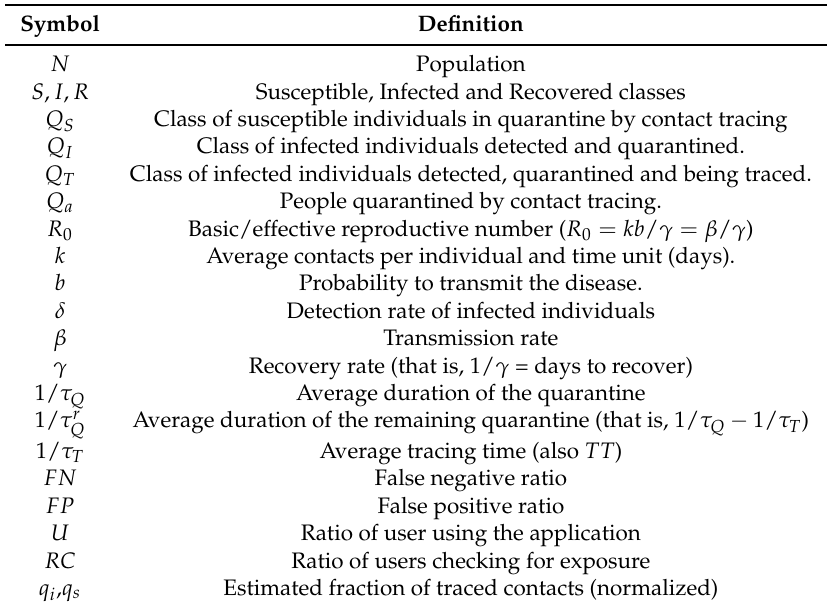
Table 1. Notation